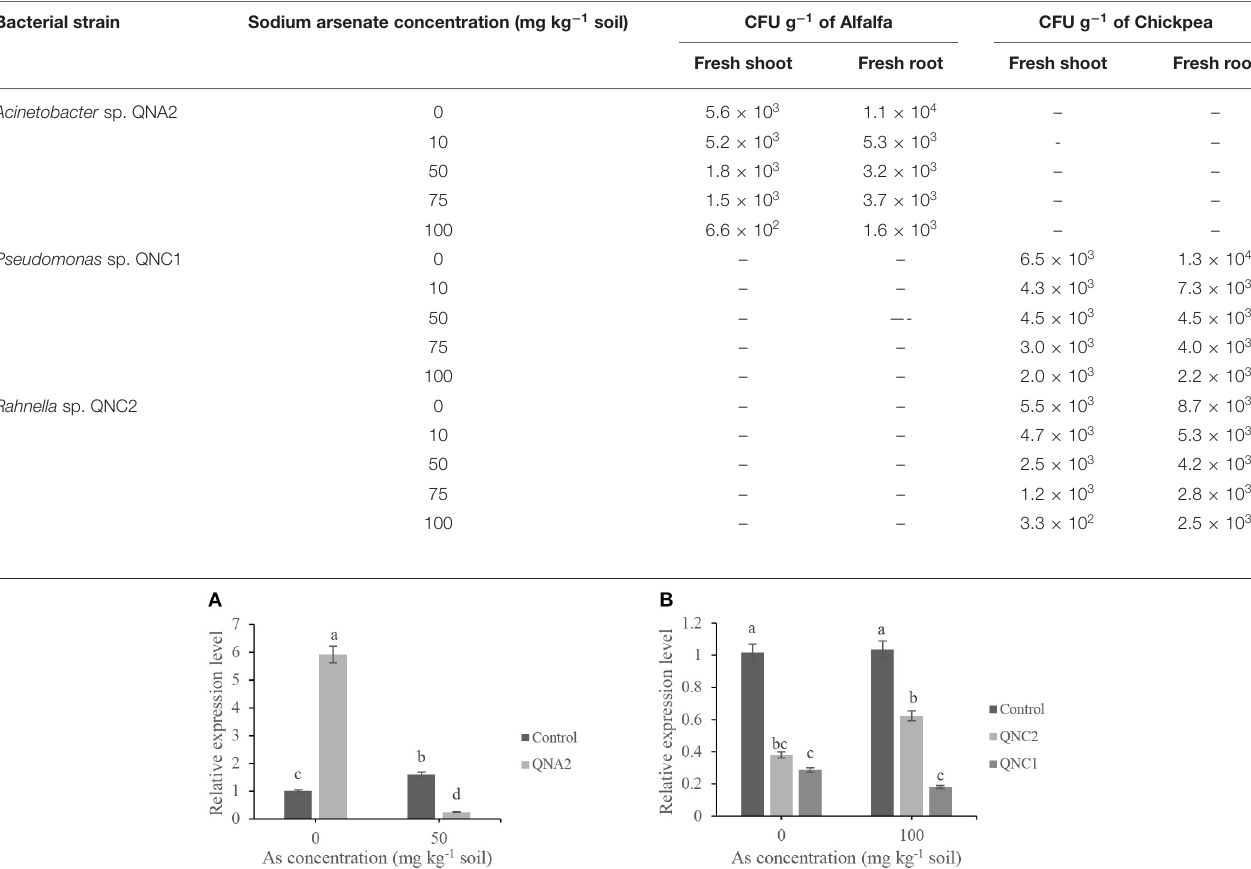
TABLE 3 | The population of Acinetobacter sp. QNA2 in shoots and roots of alfalfa plants, Pseudomonas sp. QNC1 and Rahnella sp. QNC2 in chickpea plants grown in soils, containing 0-, 10-, 50-, 75- and 100-mg kg − 1 sodium arsenate 10 days after treatment. Bacterial strain Sodium arsenate concentration (mg kg − 1 soil)